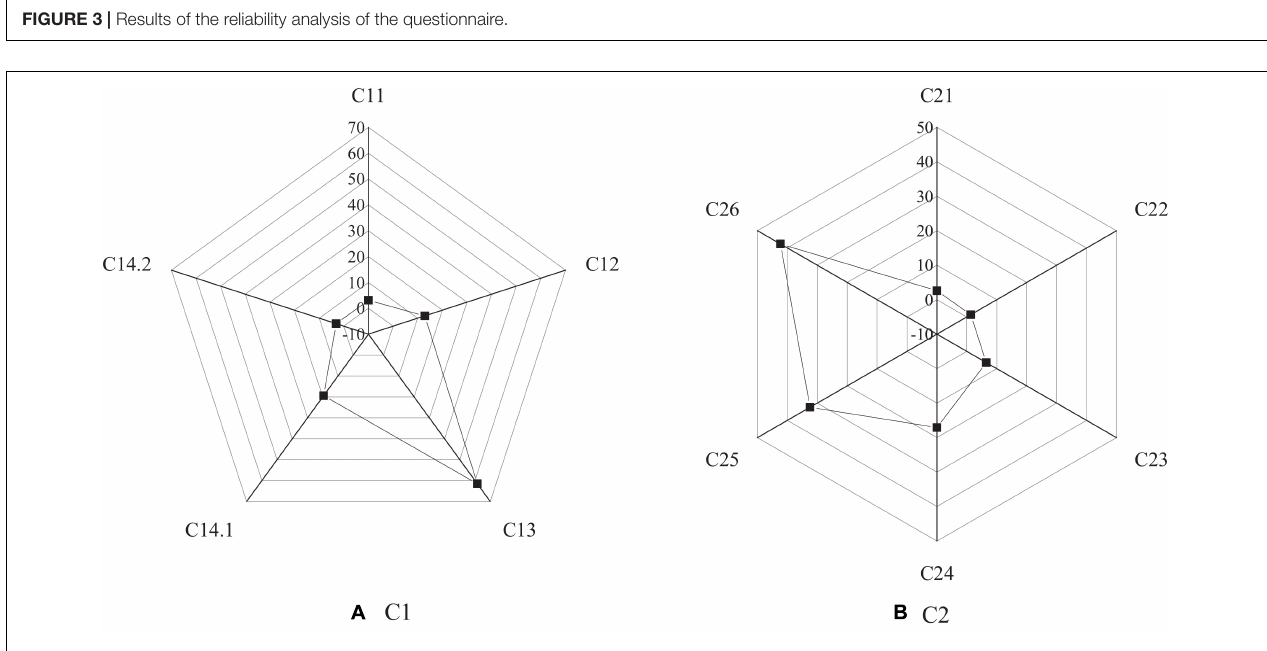
FIGURE 4 | Survey results based on options (A) C1 and (B)